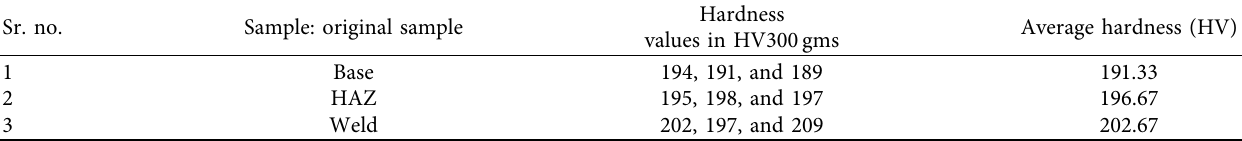
Table 1: Microhardness values in sample 1 (original).